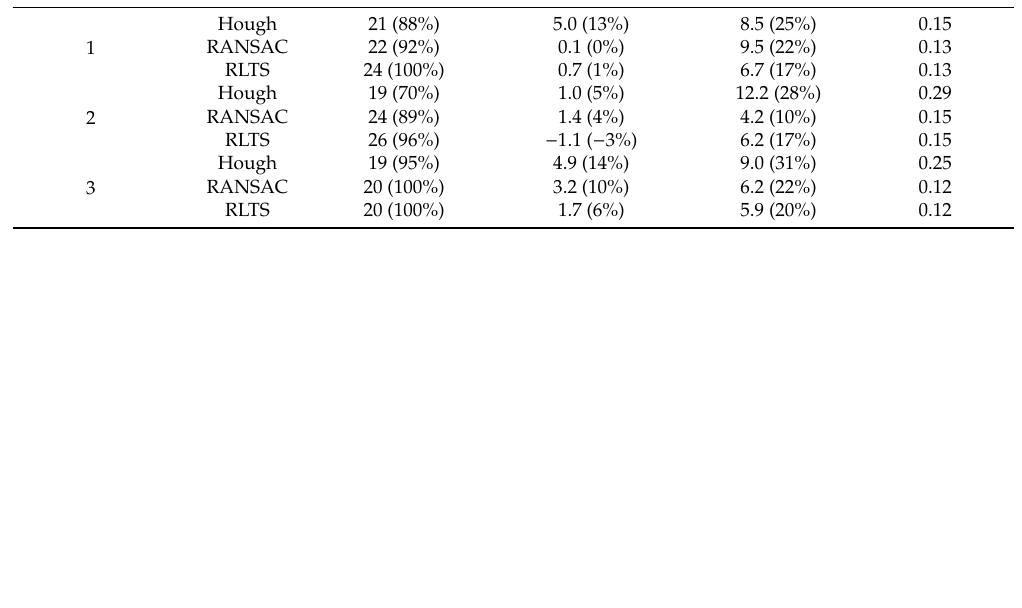
Table 3. Results of diameter estimation. Table shows counts of trees that allowed for diameter at breast height (DBH) estimation and the respective percentage of present trees (Measured), mean error and RMSE of DBH estimation and mean positional error of detected trees (Position).